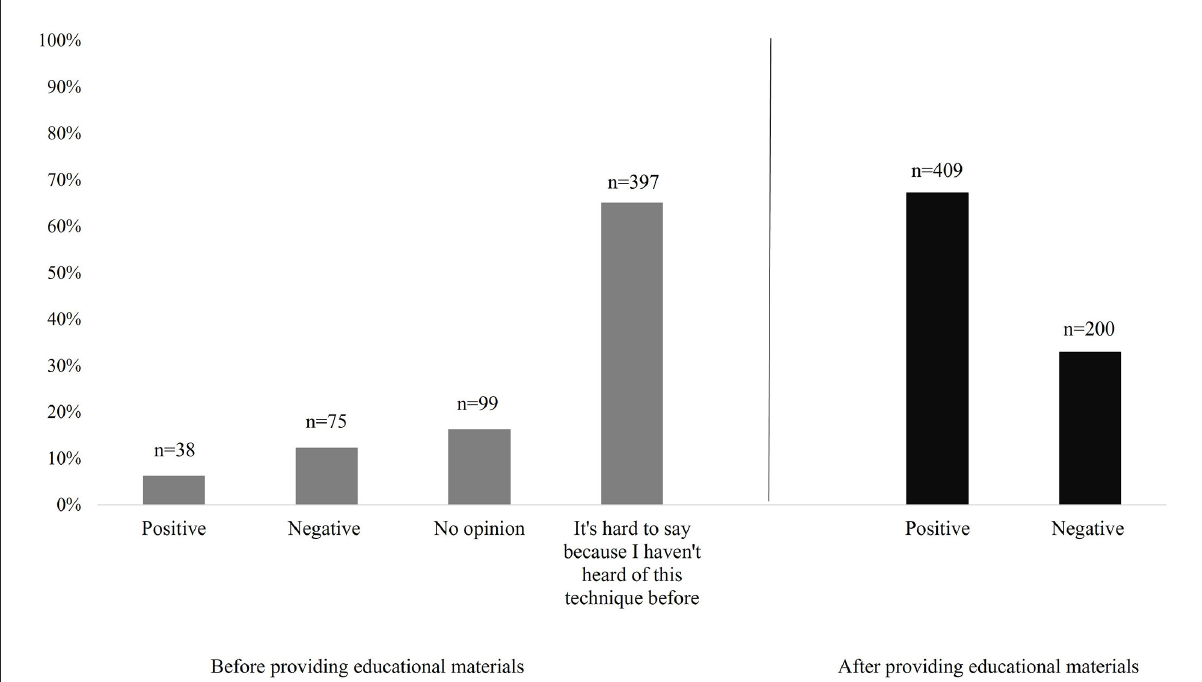
FIGURE2 The attitudes of respondent toward food irradiation before and after providing educational materials.